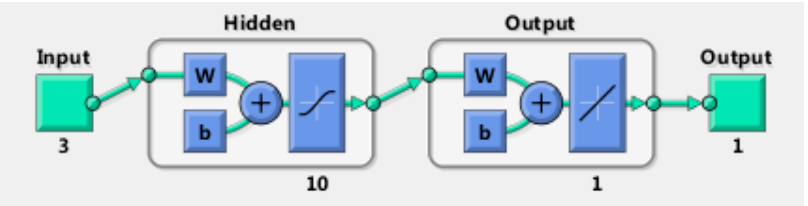
Figure 7. Structure diagram of the neural network.